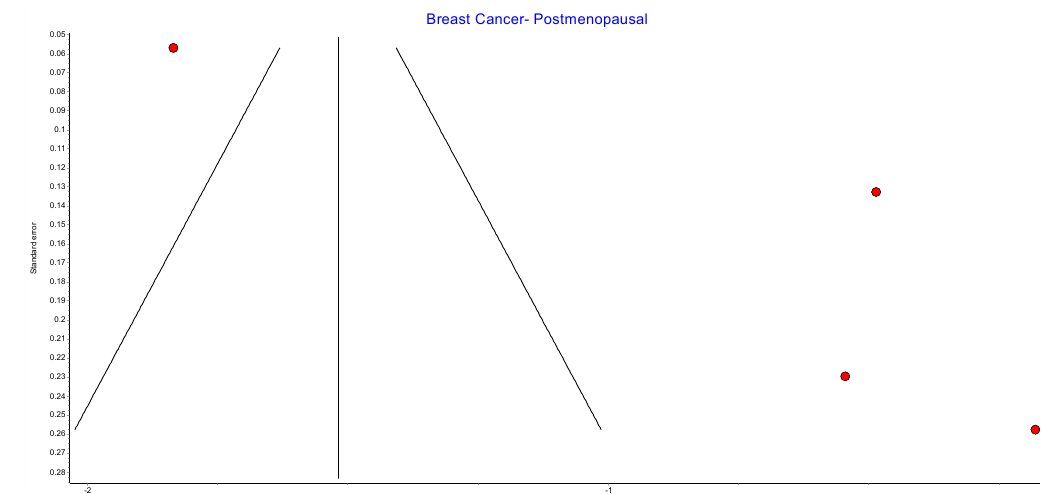
Figure A6. Postmenopausal breast cancer random effects model funnel plot.